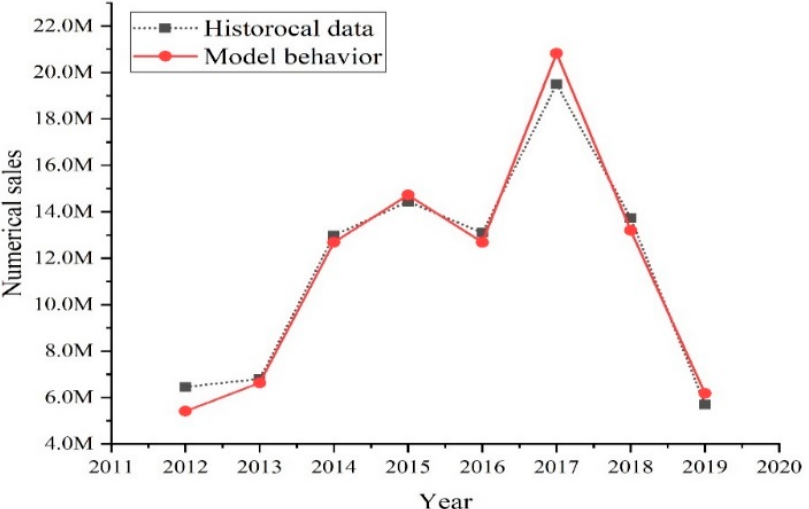
Figure 4. Comparison of historical data (real data) of the numerical sales of Valsartan 80 mg of Factory A with the model behavior .